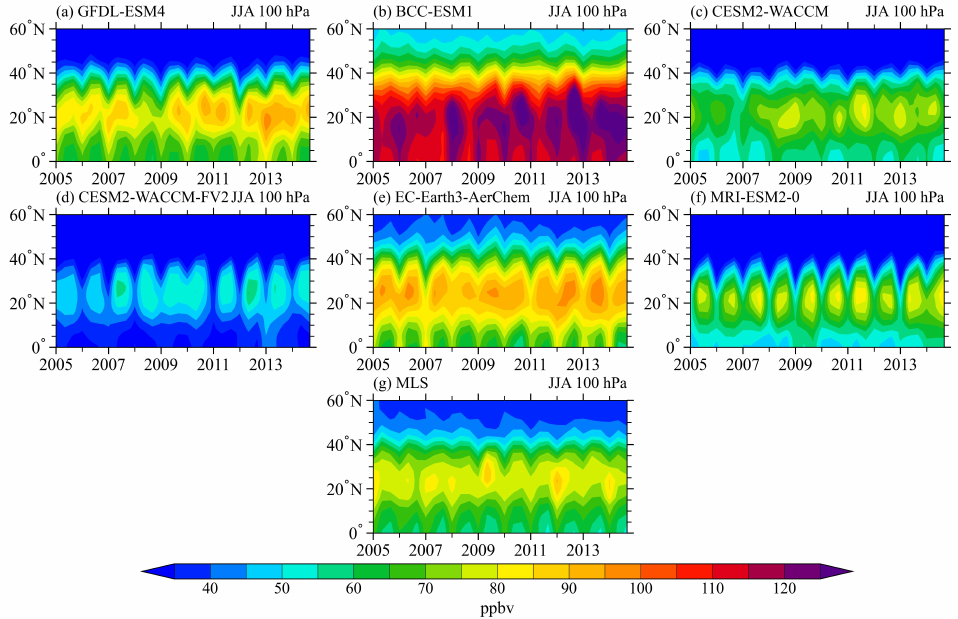
Figure 5. Latitude-time variations of CO mixing ratio (ppbv) at 100 hPa from models ( a – f ) and MLS data ( g ). CO mixing ratio is averaged over 30 ◦ –130 ◦